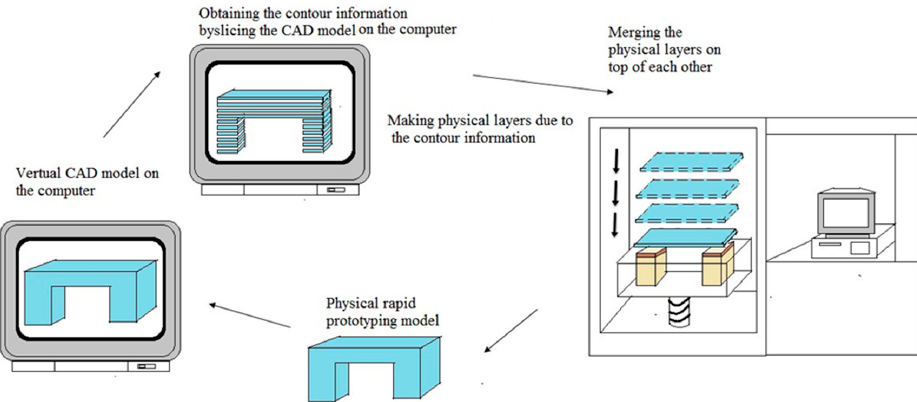
Figure 11. The schematic diagram of rapid prototyping technique.